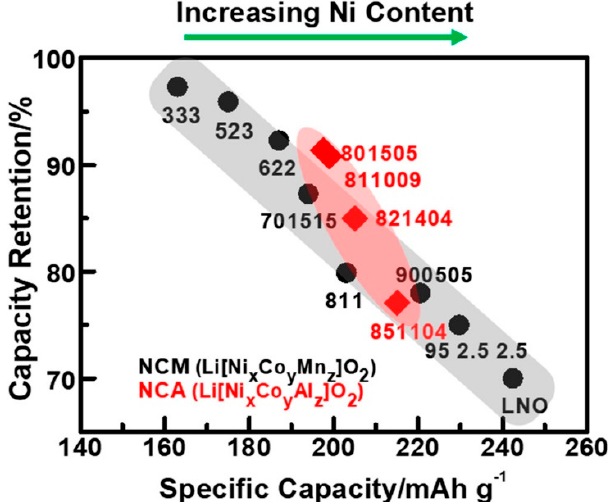
Figure 1. Specific capacity (mAh g − 1 ) versus capacity retention over 100 cycles (%) plot of various layered NCM and NCA cathodes showing the trade-o ff between stability and capacity at increasing Ni content. Compounds are labelled by their composition (Ni, Co, Mn) = x : y : z . Reproduced from [16]. Copyright 2017. The American Chemical Society.